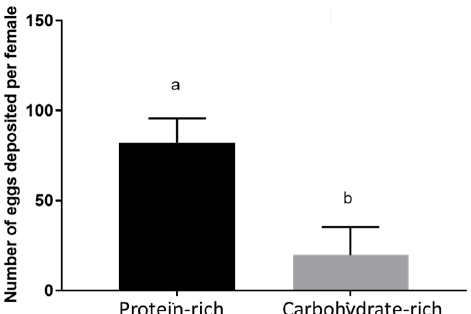
Figure 3. Effect of larval diets on fecundity. A subset of five females per treatment were kept individually in small containers lined with moist paper towels to provide an oviposition surface. The number of eggs deposited by individual females was counted five days post-blood meal. Mean ± standard error were plotted. Data were analyzed by t-test (t=9.599 df=18), P<0.0001. Experiments were replicated thrice with different cohorts. N=15.